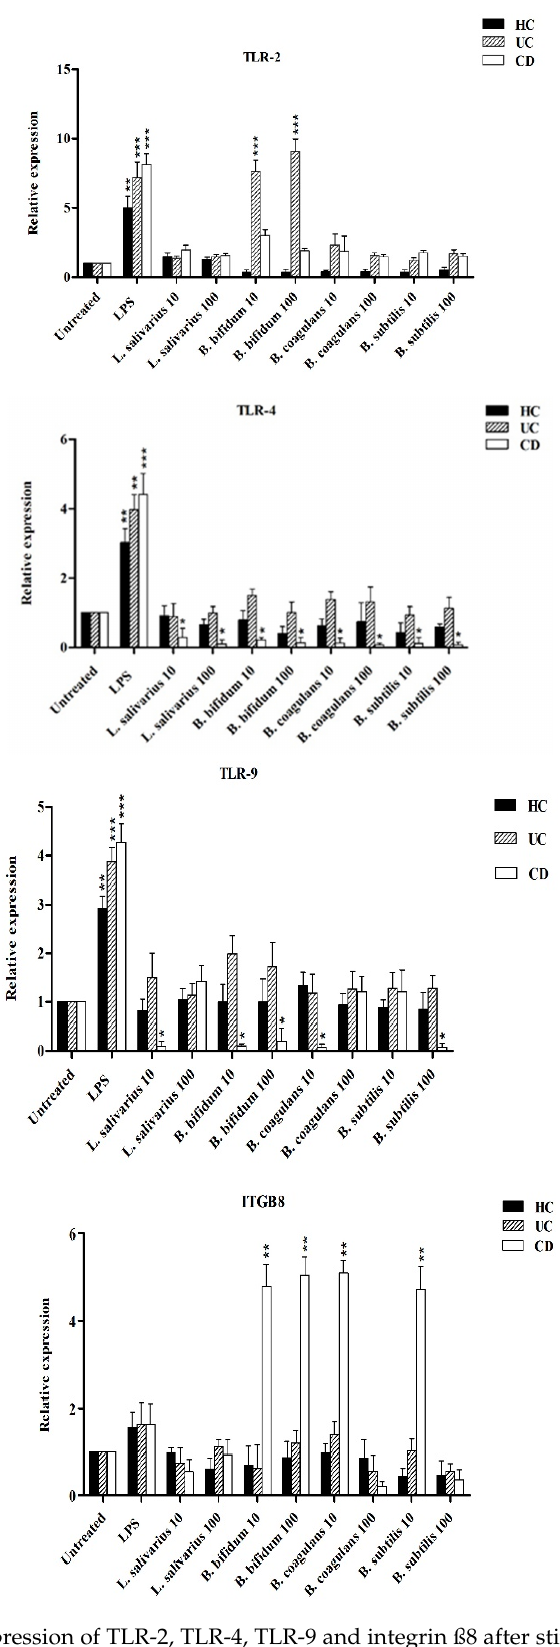
Figure 6. Relative expression of TLR-2, TLR-4, TLR-9 and integrin ß8 after stimulation of DCs with probiotic bacteria. * p < 0.05, ** p < 0.01, and *** p < 0.001. probiotic bacteria. * p < 0.05, ** p < 0.01, and *** p <